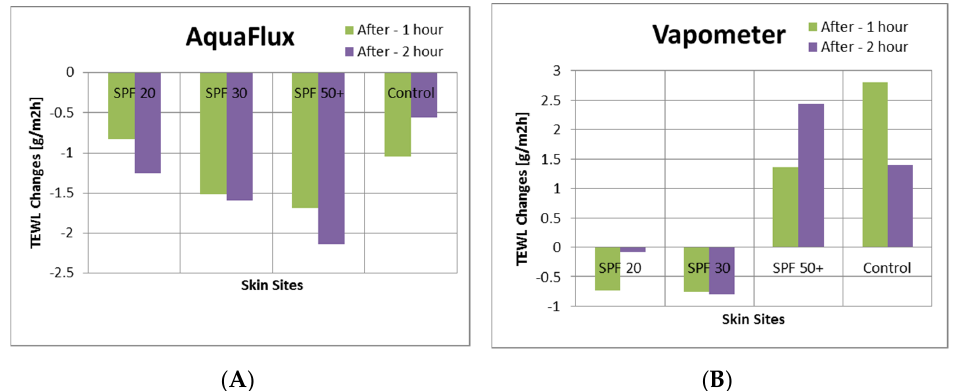
Figure 4. The TEWL value changes before and after sunscreen application, measured by AquaFlux ( A ) and VapoMeter ( B ).